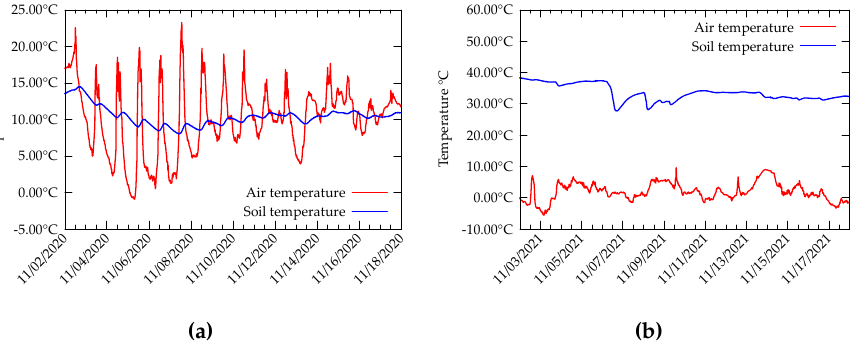
Figure 1. Soil and air temperature data collected from ( a ) Campus Drie Eiken of University of Antwerp in Belgium for the month of November 2020. ( b ) Forhot site in Iceland for the month of November